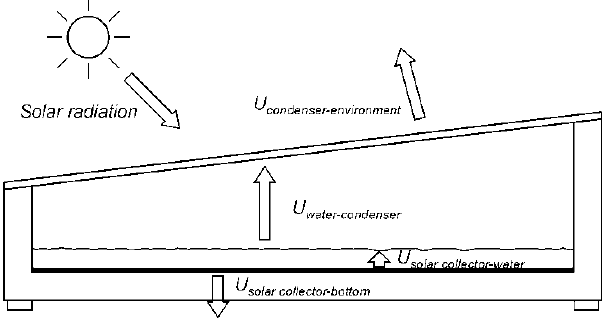
Figure 1. Single ‐ effect single ‐ slope condenser solar still. Figure 1. Single-e ff ect single-slope condenser solar still.